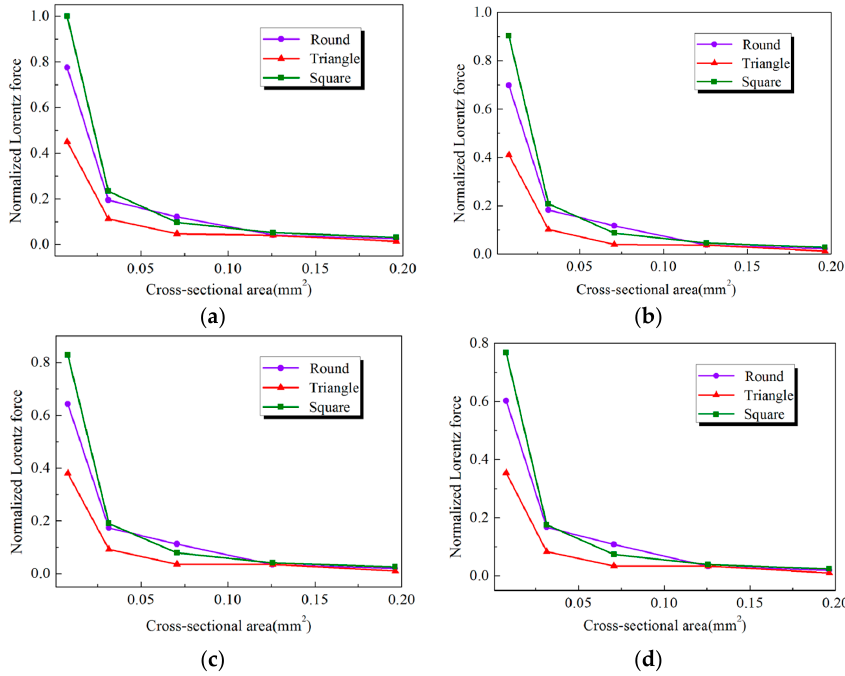
Figure 5. Normalized Lorentz force in skin depth with different coil cross-sectional areas and cross-sectional shapes. ( a ) f = 1 MHz; ( b ) f = 1.5 MHz; ( c ) f = 2 MHz; ( d ) f = 2.5 MHz .